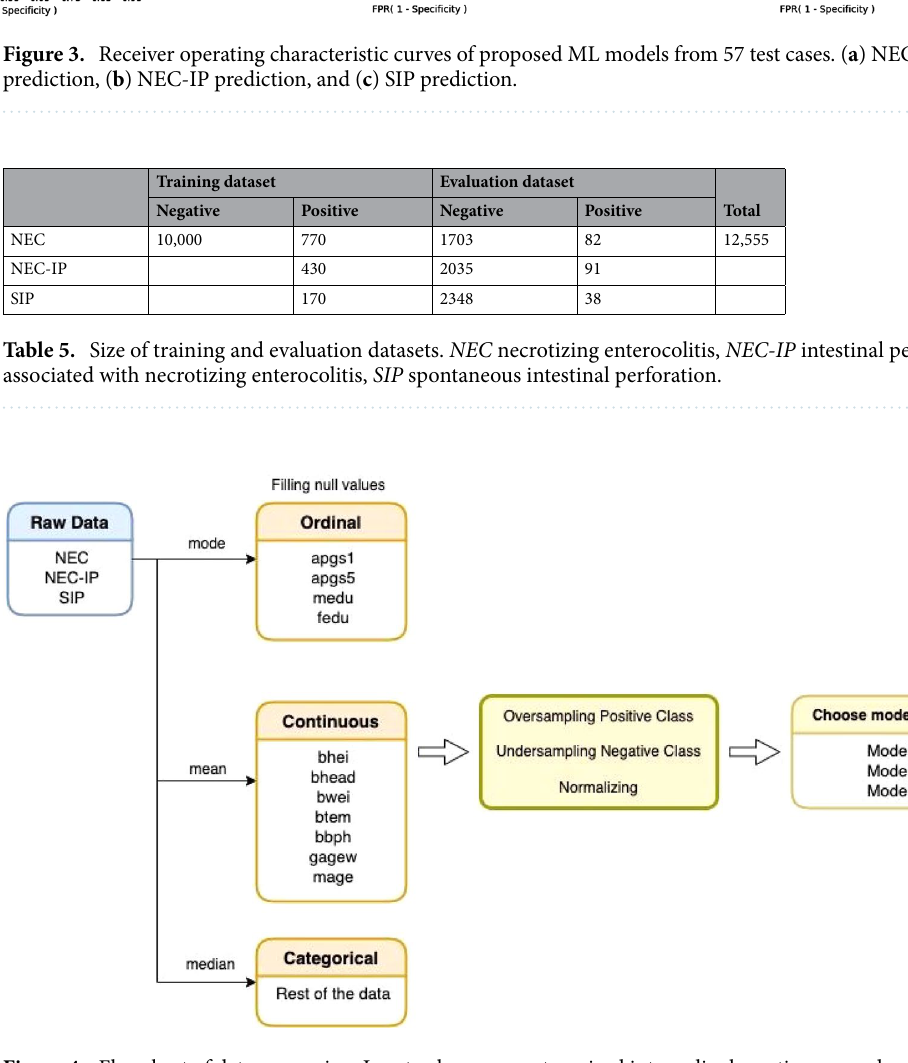
Figure 4. Flowchart of data processing. Input values were categorized into ordinal, continuous and categorical types. To solve the data imbalance problem, oversampling and undersampling technique were applied. Then, the data were